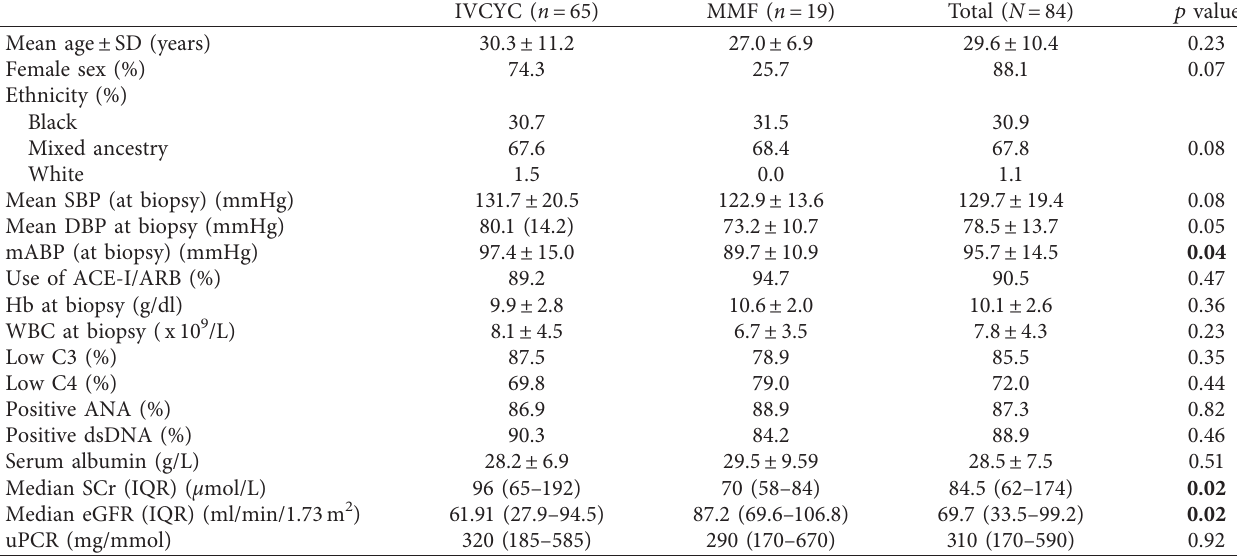
Table 1: Baseline demographic and clinical characteristics of study